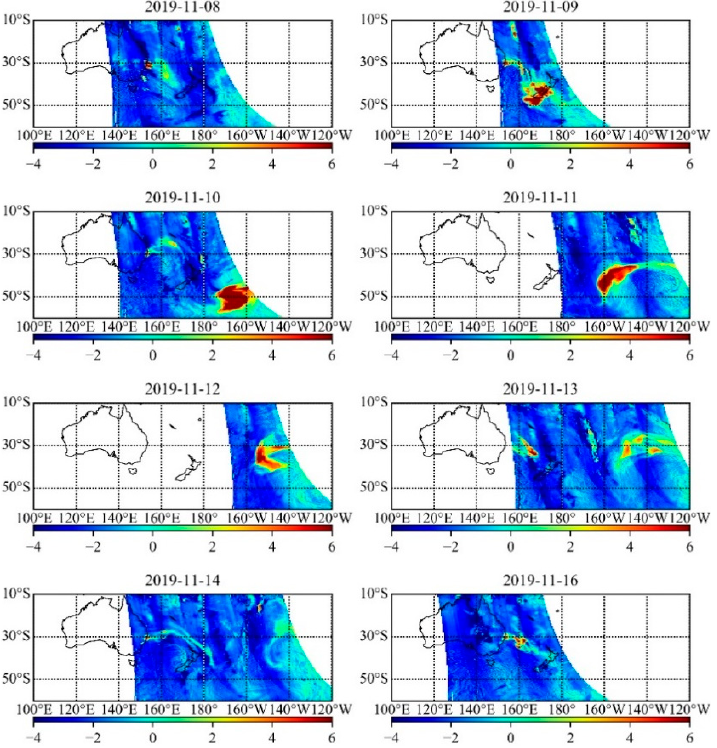
Figure 11. Distribution of AAI from EMI observations of the Australian wildfires from 8 to 16 November 2019, showing biomass burning transported by winds in the atmosphere.